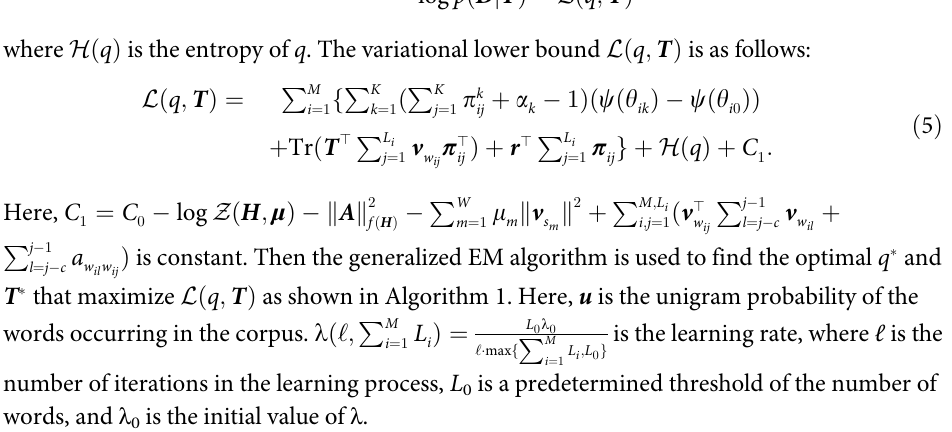
Algorithm 1 The generalized EM